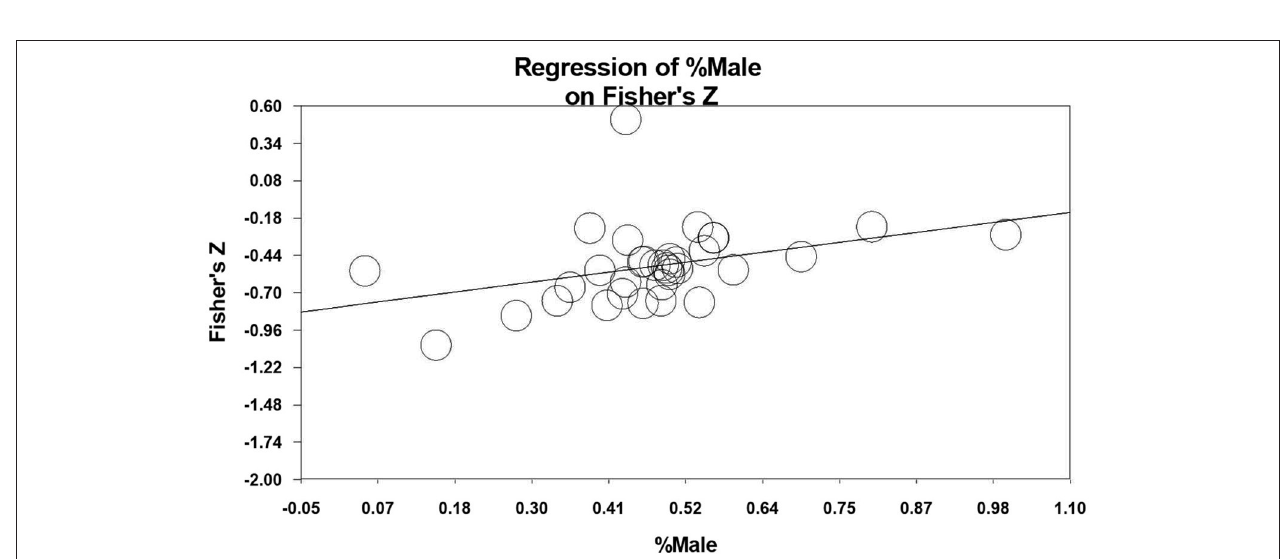
FIGURE 3 | Meta-regression of the percentage of males on the relationship between resilience and student